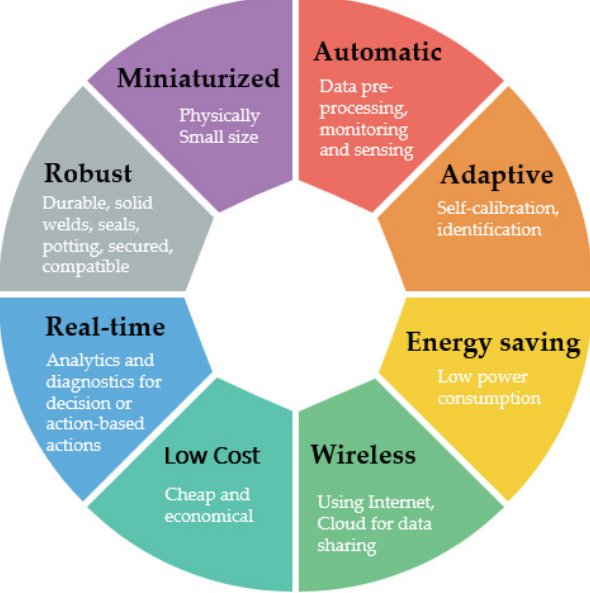
Figure 10. Main characteristics of intelligent sensors.